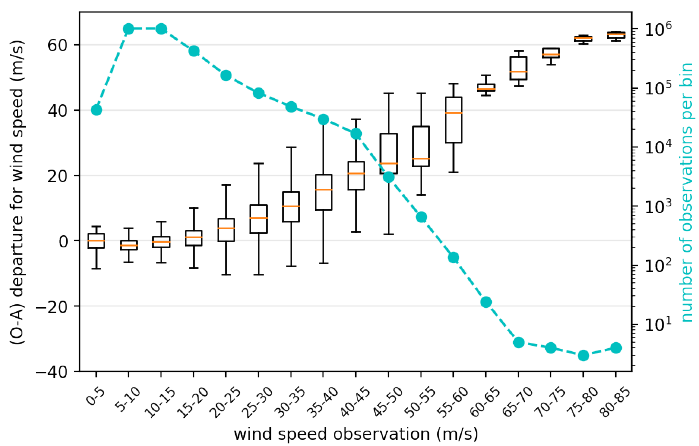
Figure 1. (O-A) for wind speed with respect to SAR wind speed observations. SAR wind speed data are binned in 5-m · s − 1 intervals. Each box extends from the lower (Q1) to upper quartile (Q3) values of the data, with a red line at the median.The whiskers represent the 1.5 interquartile range (IQR). The green dotted line shows the number of observations in each